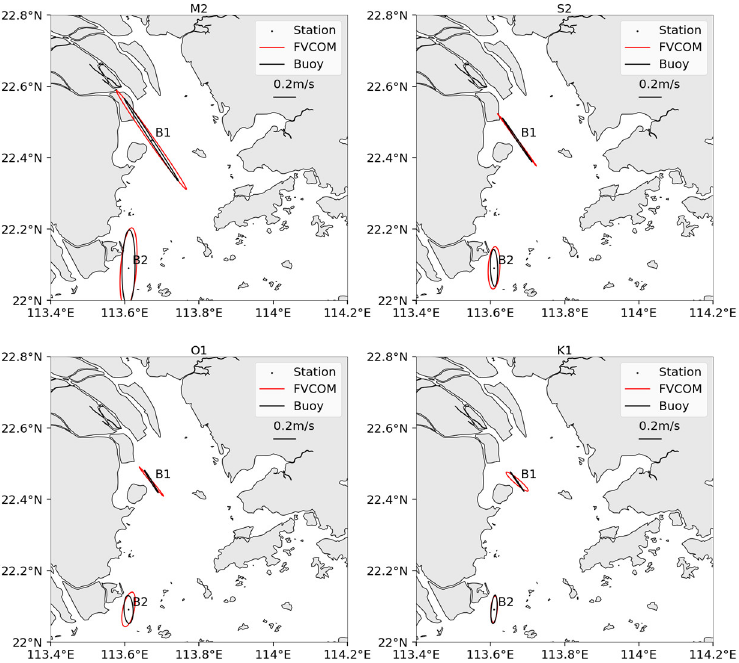
Figure 4. Comparisons of buoy-derived and model tidal ellipses for M 2 , S 2 , O 1 , and K 1 constituents.